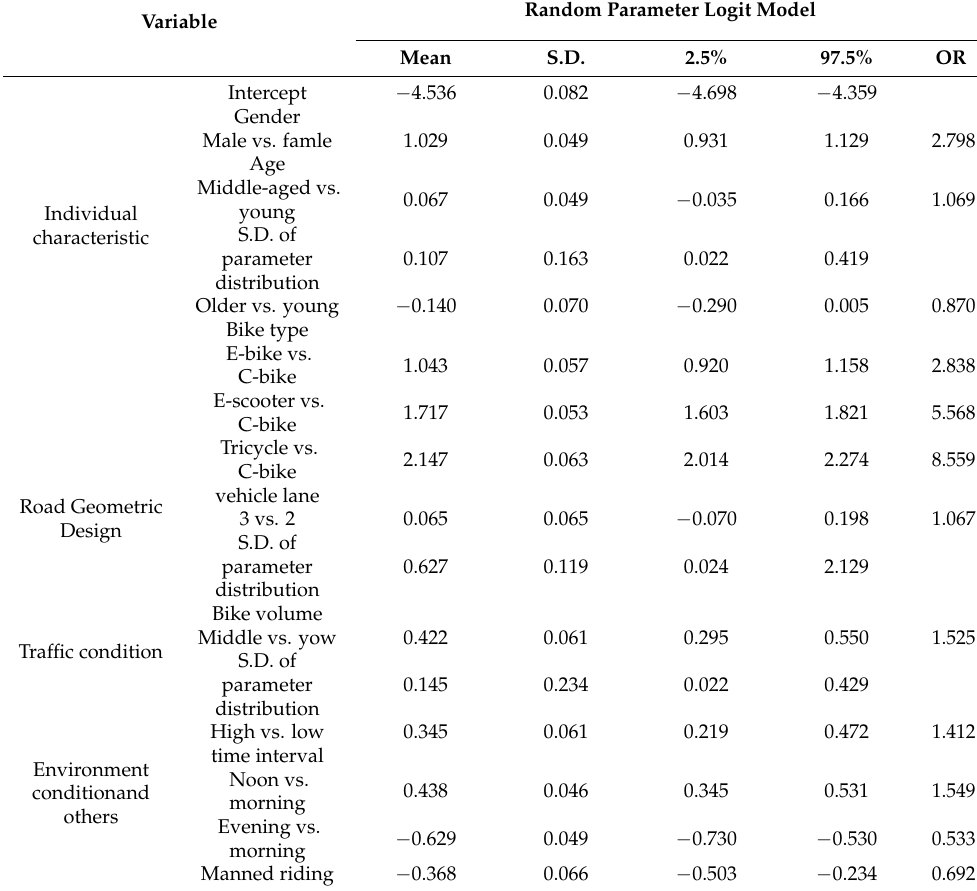
Table 6. Estimation from the Bayesian random parameters logit model at bike lanes separated with